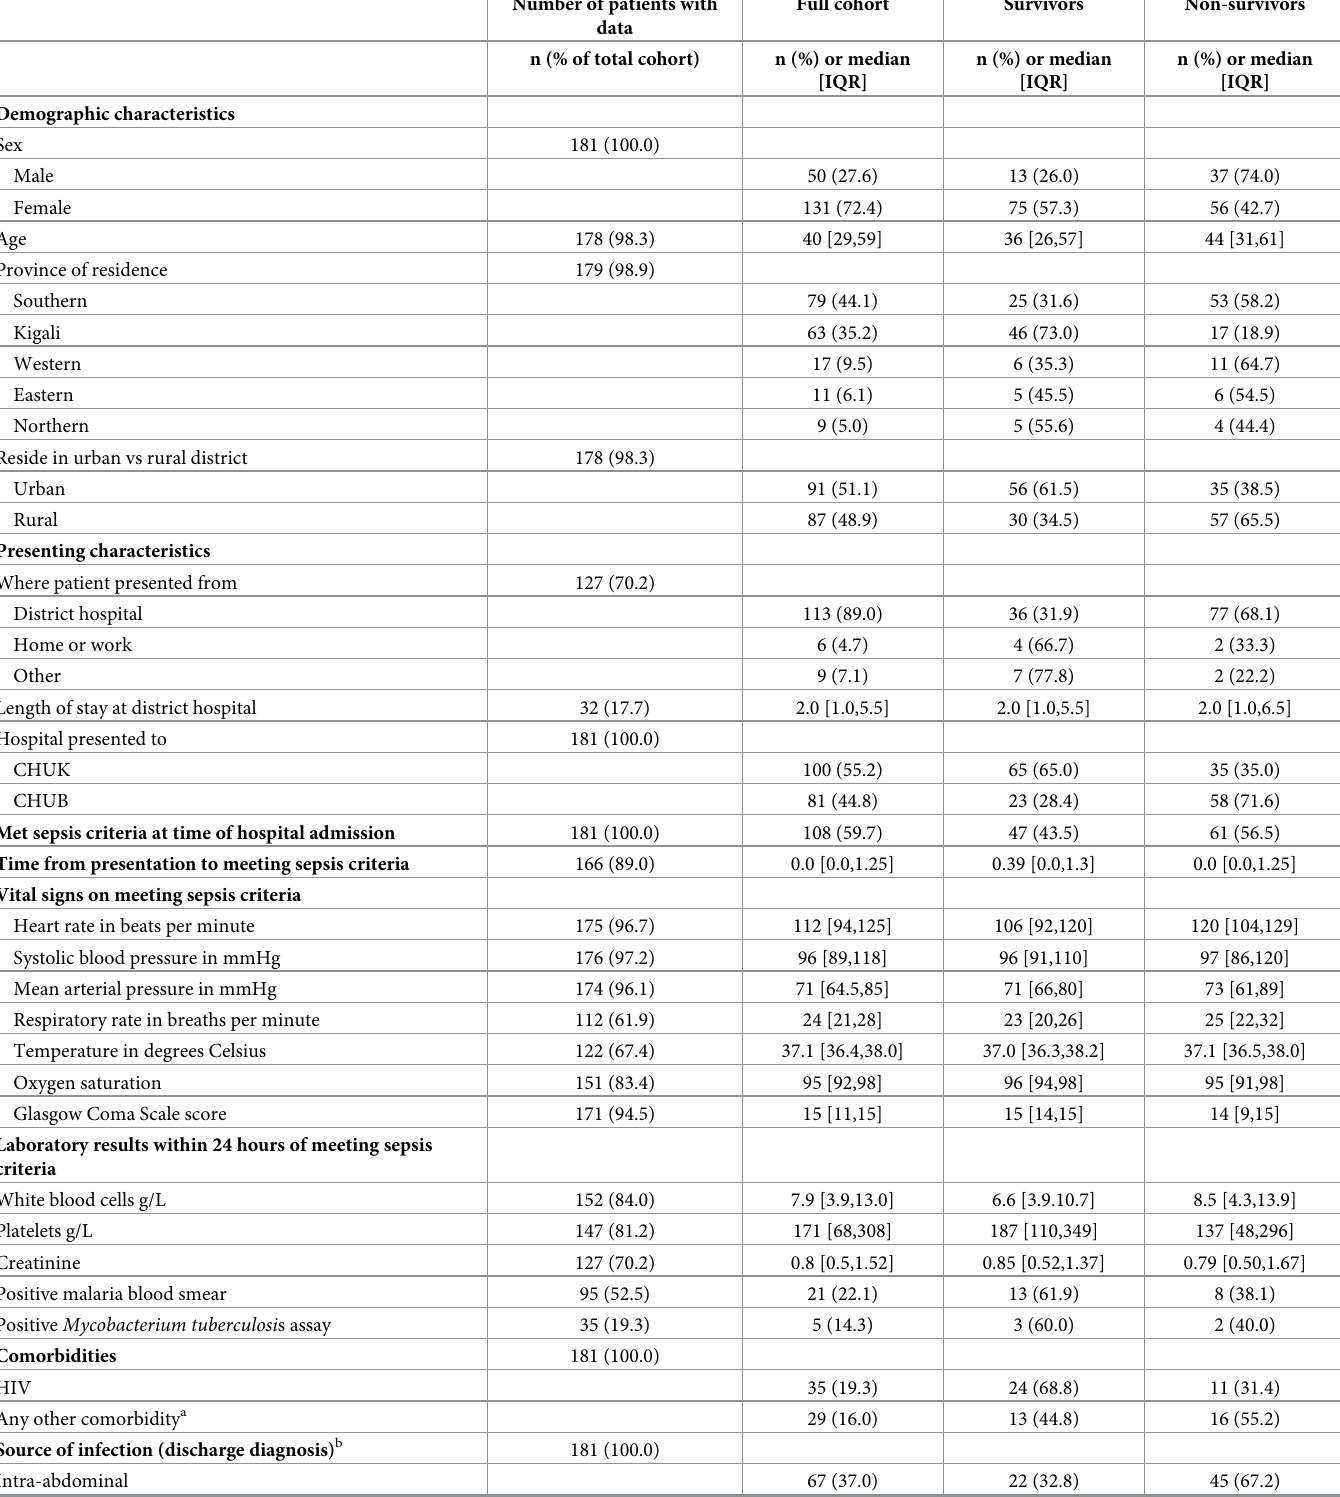
Table 1. Demographic and baseline